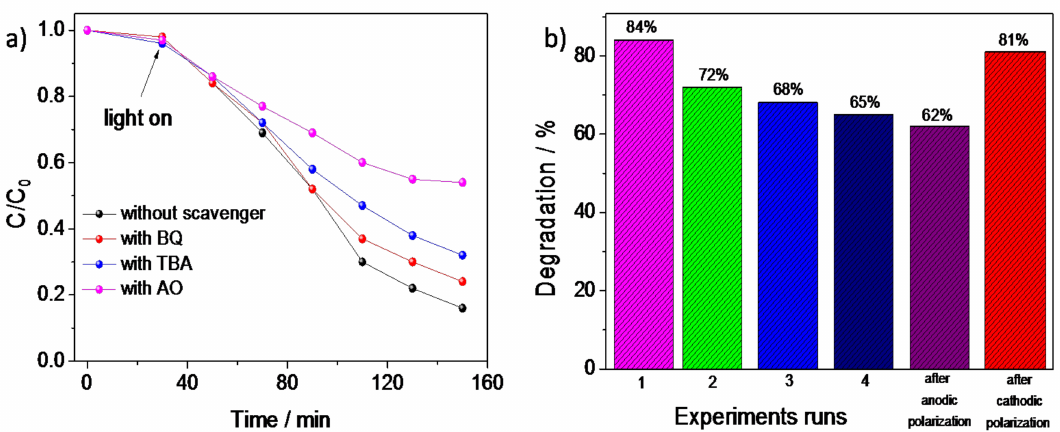
Figure 10. (a ) The influence of di ff erent scavengers on photodegradation e ffi ciency of MB and ( b ) the degradation e ffi ciency of MB in the function of experimental